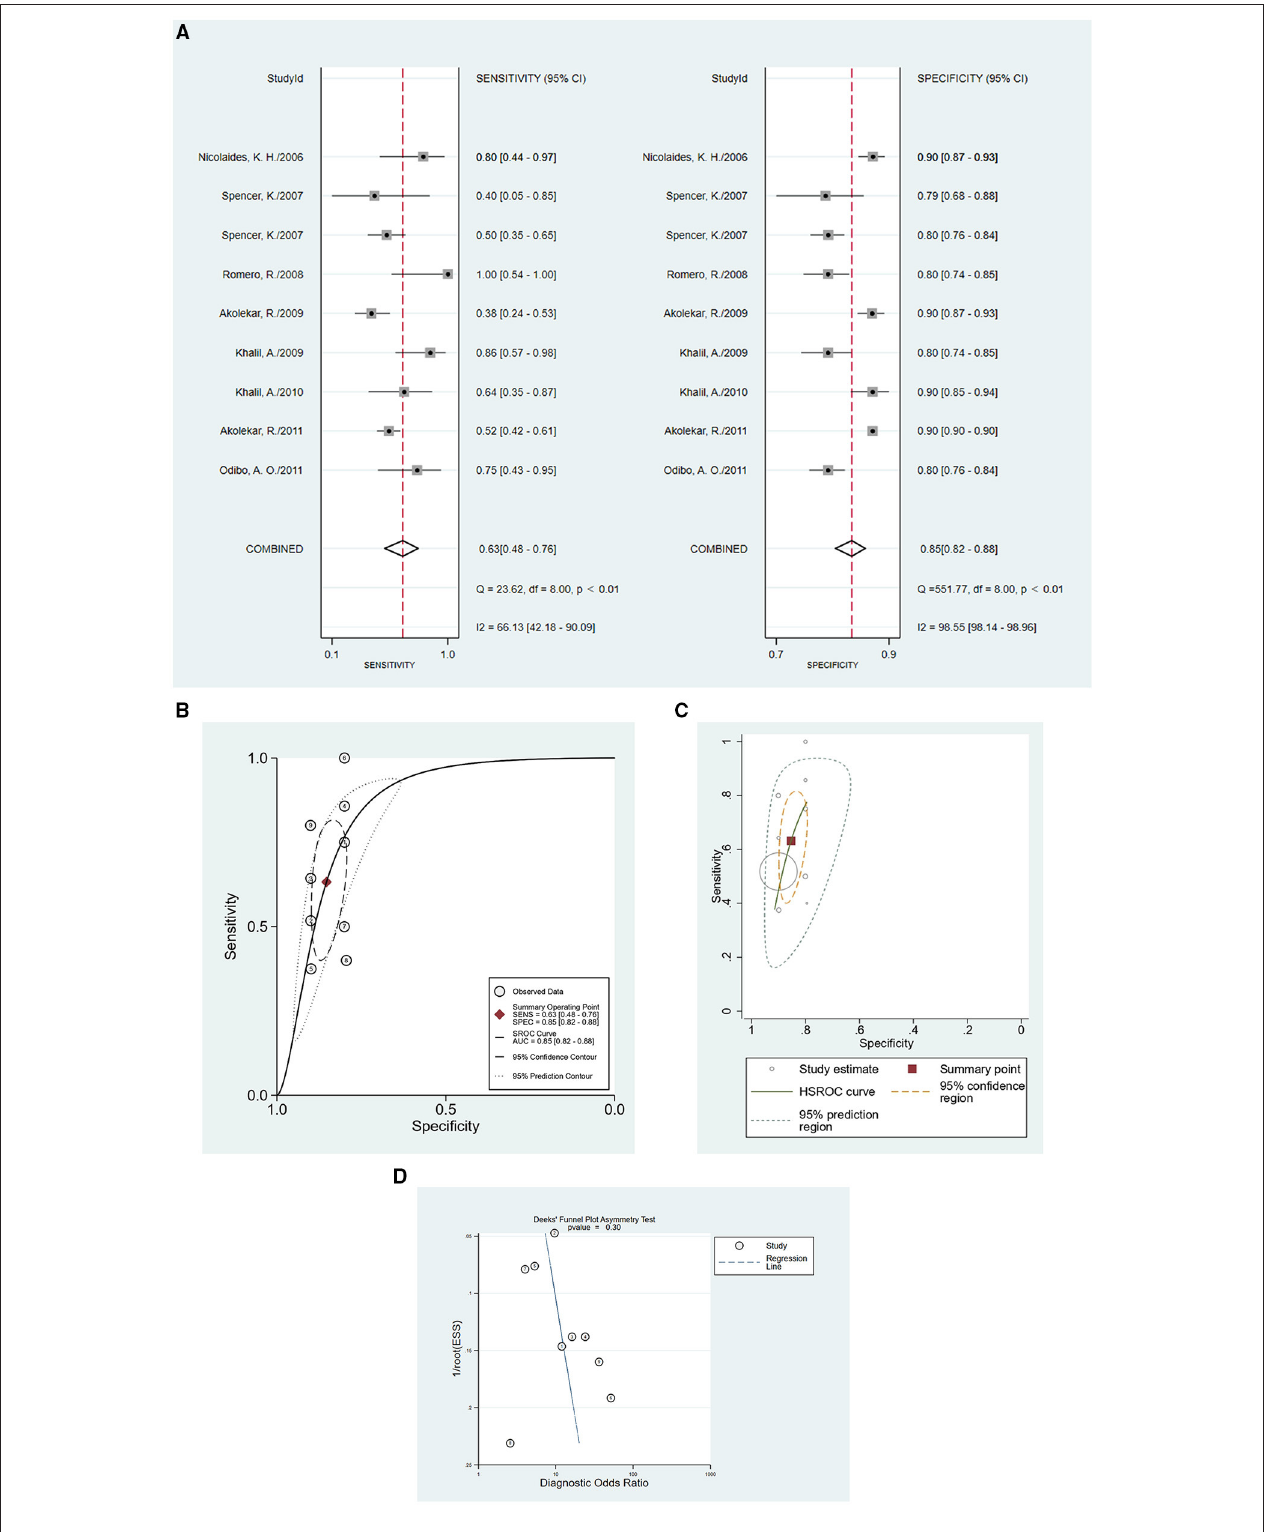
FIGURE 5 | The accuracy of PP13 as demonstrated for EO-PE by (A) forest plot, (B) SROC curve for EO-PE group, (C) HSROC curve for EO-PE group, and (D) publication bias test for EO-PE group.